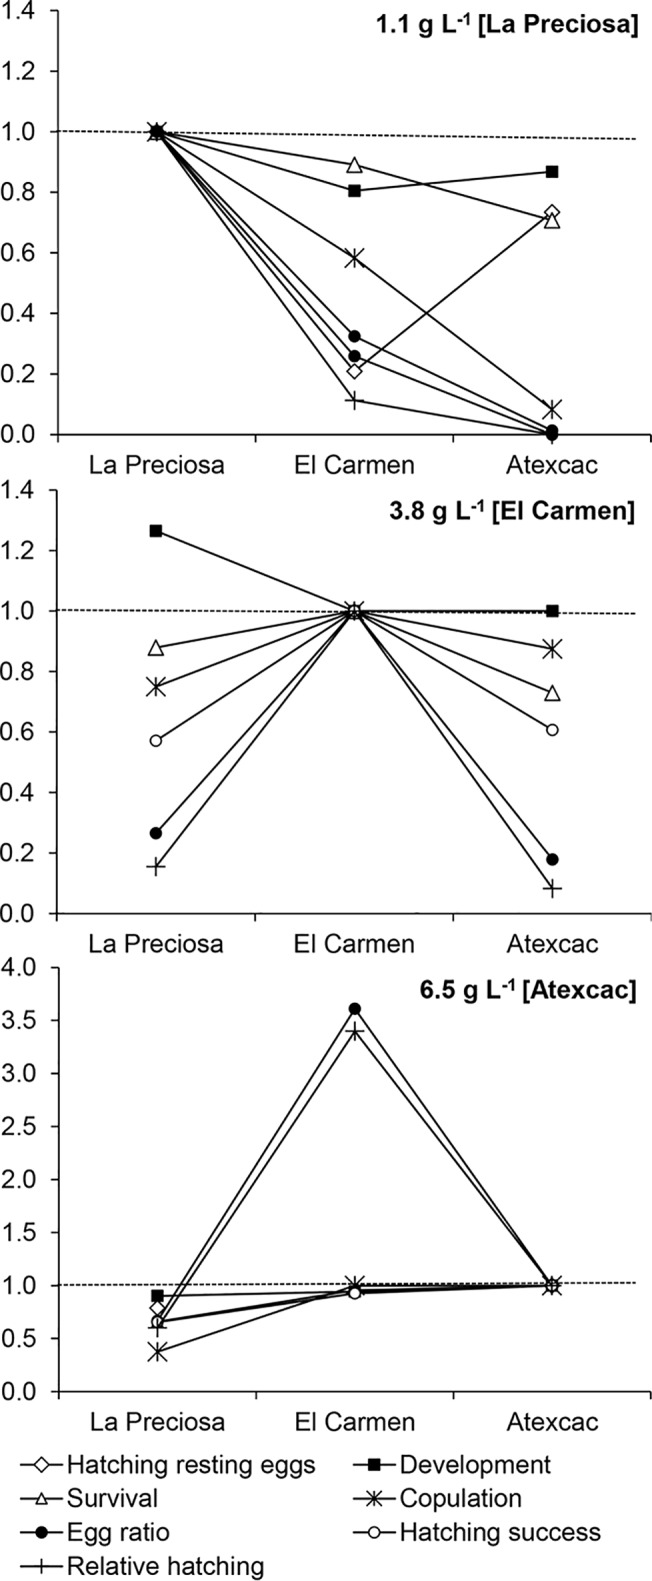
Selection against immigrants.Performance of immigrants from populations of L. cf. sicilis in different salinities relative to resident populations. Resident population between brackets. Fitness of resident populations = 1, pointed line.